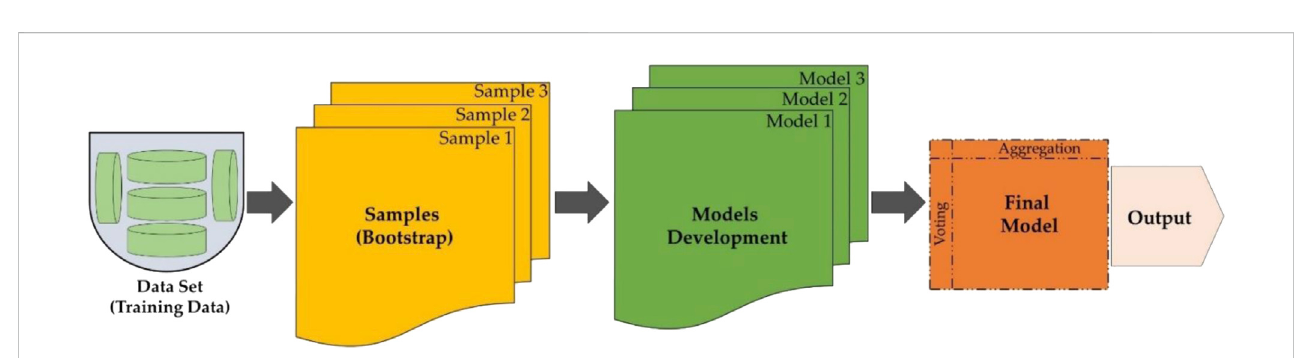
FIGURE 5 Bagging model implementation